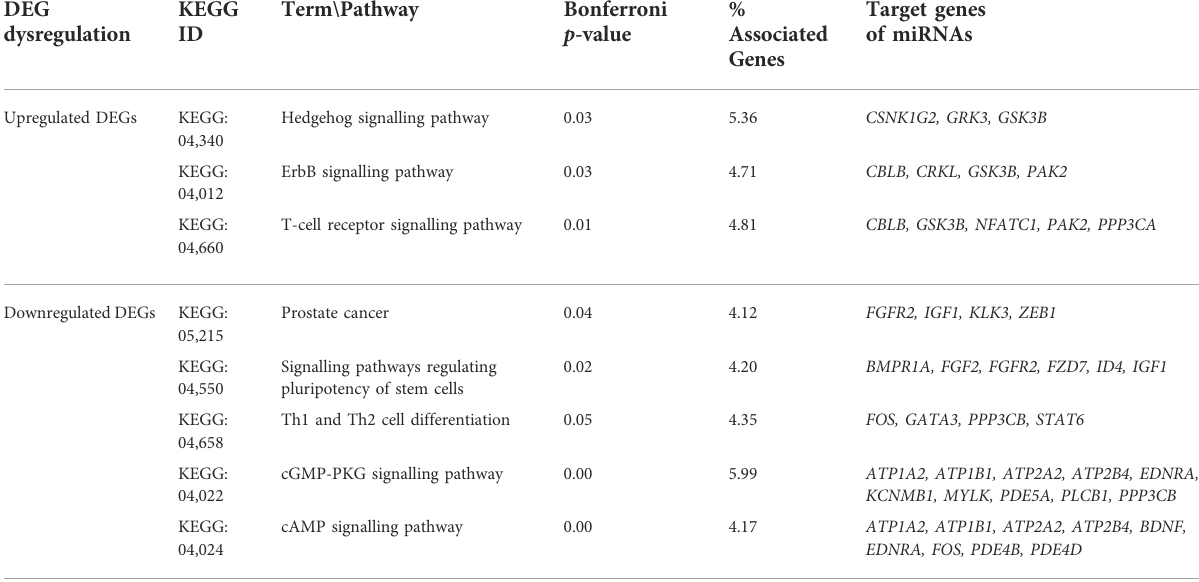
TABLE 3 KEGG pathways enriched for miRNA target genes of prostate cancer tissues. DEG